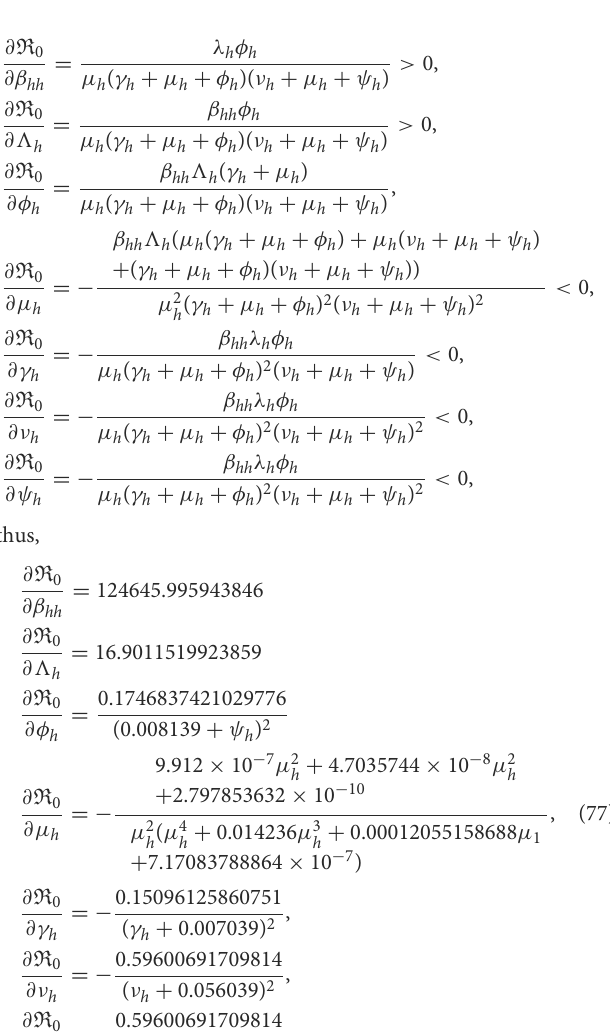
TABLE 3 The sensitivity index of R 0 with respect to parameter p of the system